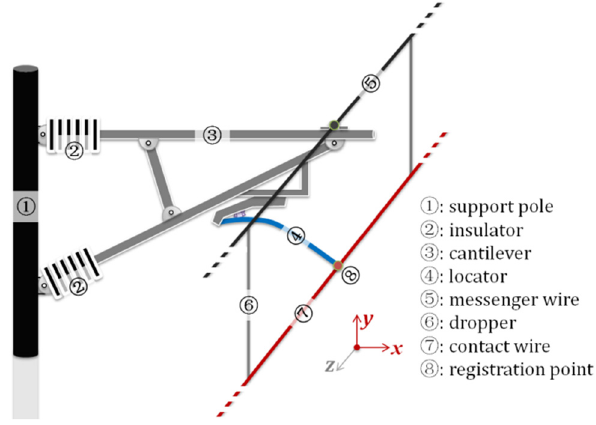
Figure 3: Railway catenary system and its components.